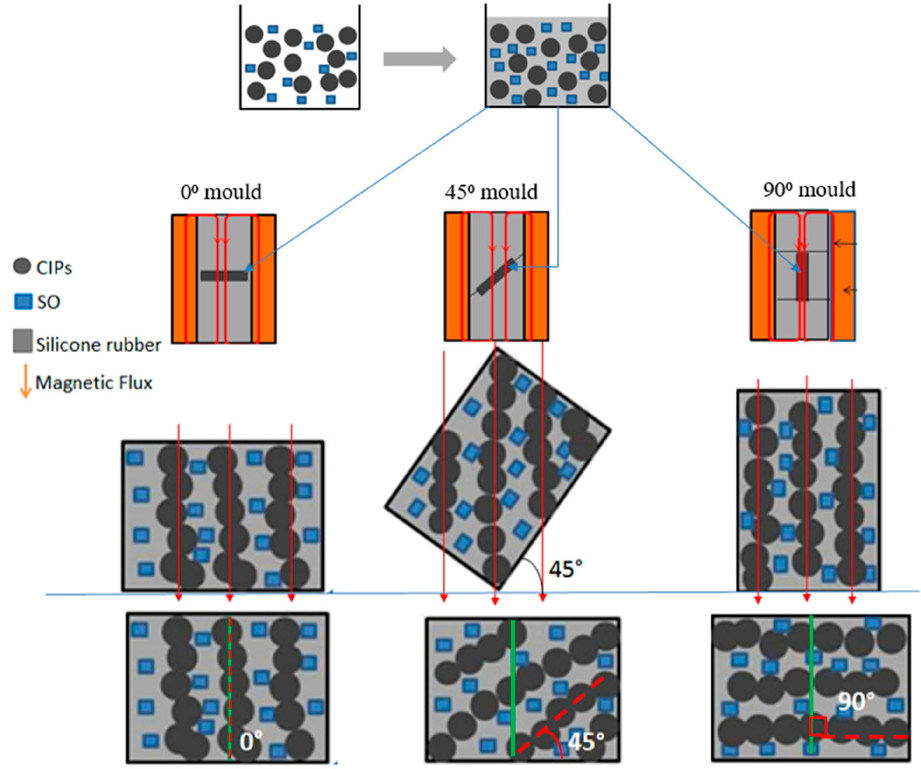
Figure 5. Illustration of CIPs orientation with 0°, 45° and 90° to the y ‐ axis during curing